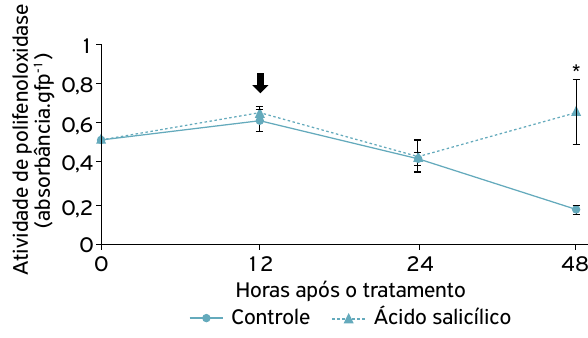
Figura 4. Atividade de polifenoloxidase em mudas de maracujá‑amarelo tratadas com ácido salicílico 2,5 mM e etanol 10% (controle) em diferentes tempos de